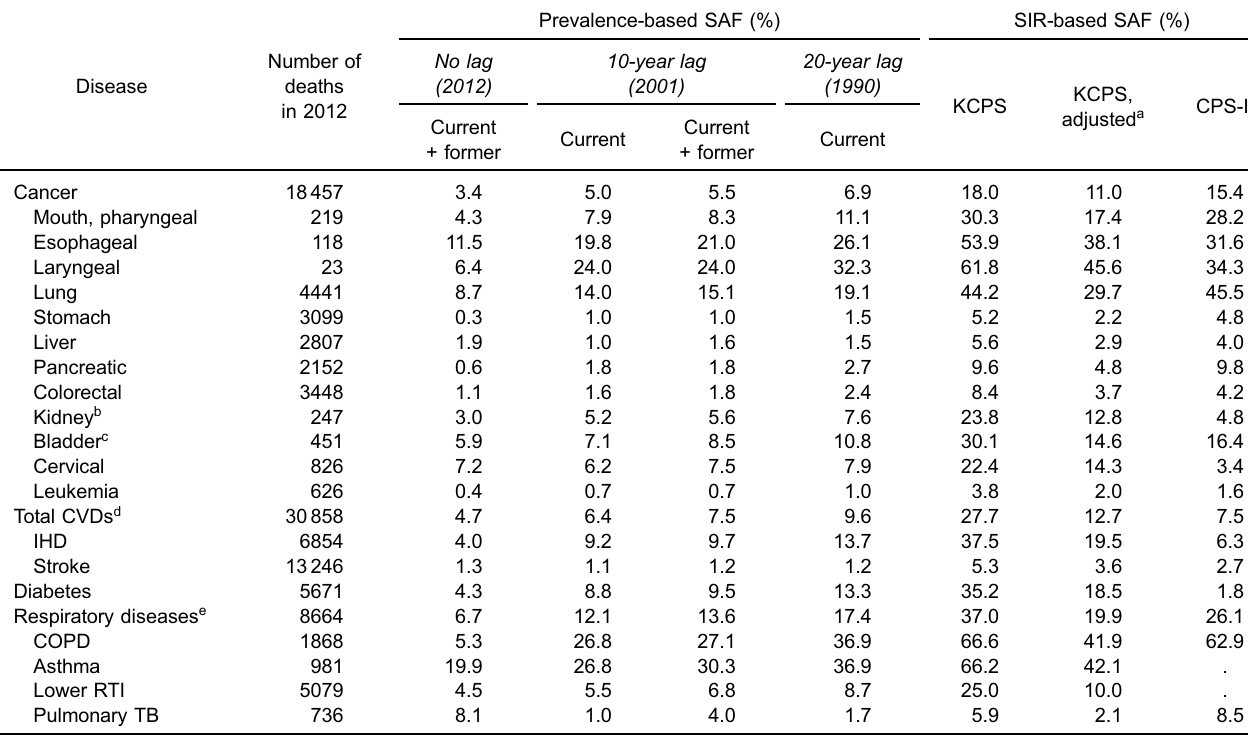
Table 4. Estimated smoking-attributable fraction of deaths among Korean females in 2012 calculated using smoking impact ratio- and prevalence-based methods